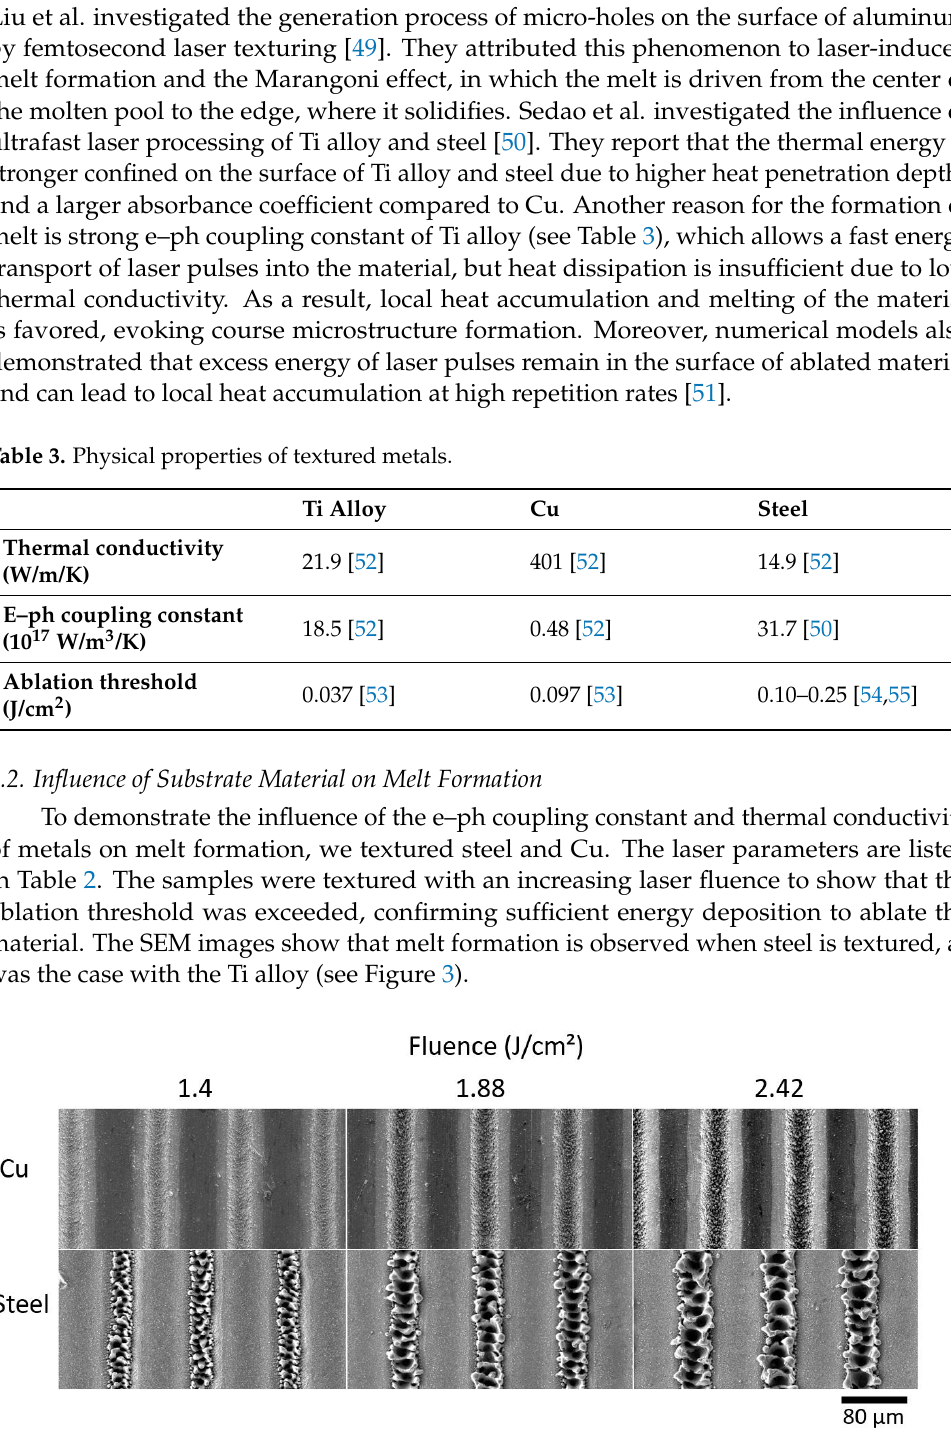
Figure 3. SEM images of microstructures on steel and copper fabricated with a repetition rate of 500 kHz at pulse overlap 99.93%. 500 kHz at pulse overlap